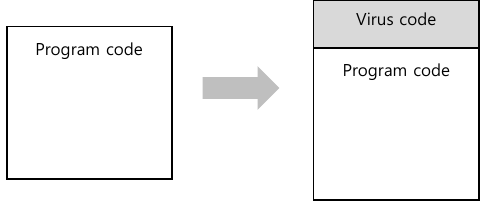
Fig. 1. The example of an infection by a prepending virus. Fig. 1: The example of an infection by a prepending